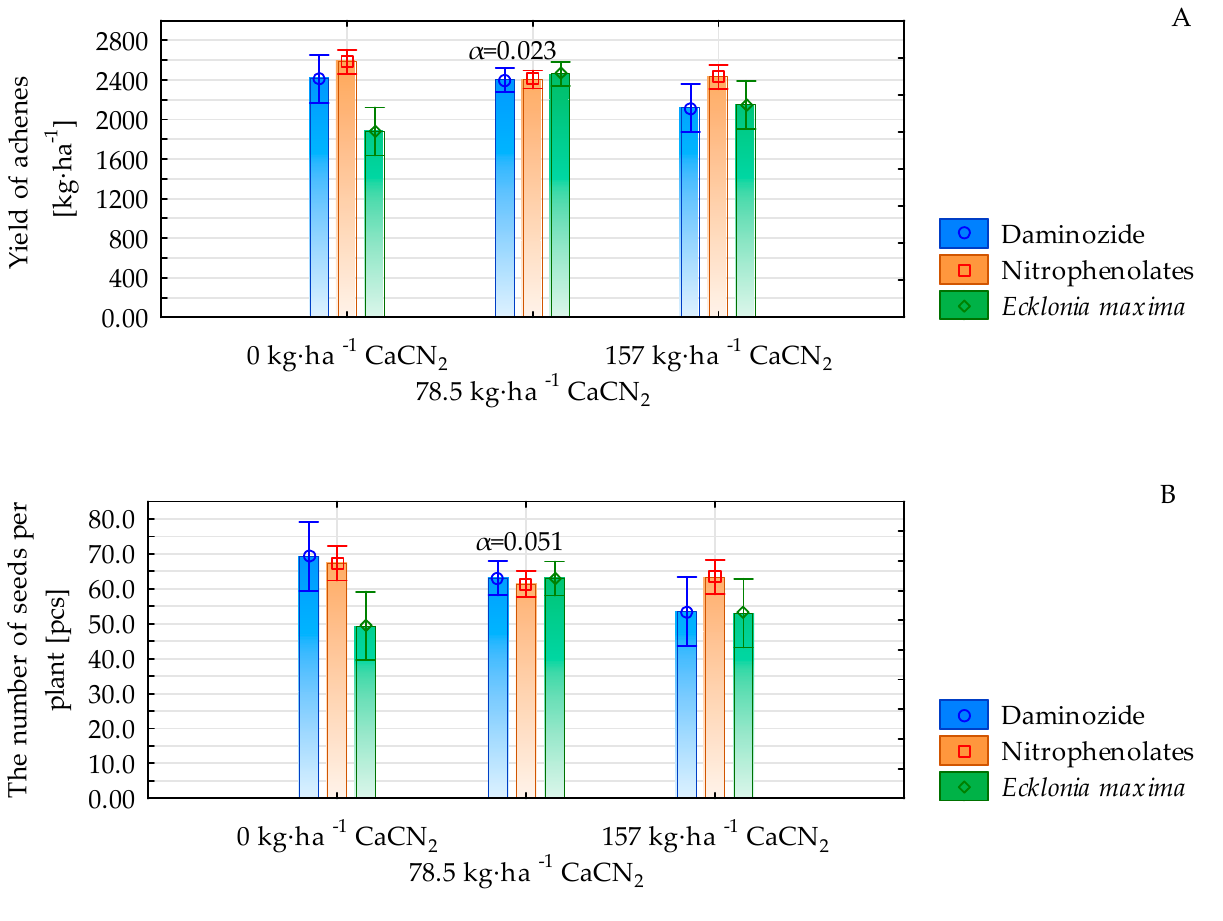
Figure 1. Achenes yield ( A ) and number of seeds per plant ( B ).